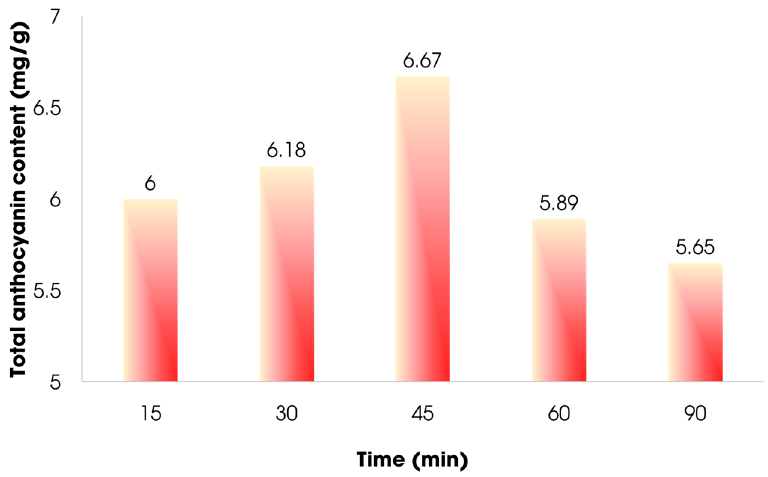
Figure 5. Extraction yields under different extraction durations.